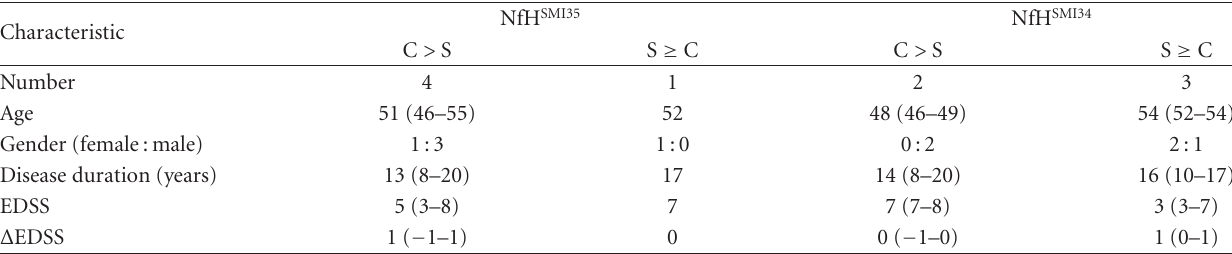
Table 3: Primary progressive MS. The patients were classified according to the relationship of CSF and blood NfH levels. If the concentration was higher in the CSF compared to the blood, this was indicated by “C > S” and “S ≥ C” otherwise. The data is presented for each of the two NfH phosphoforms quantified (NfH SMI34 and NfH SMI35 ). Characteristic